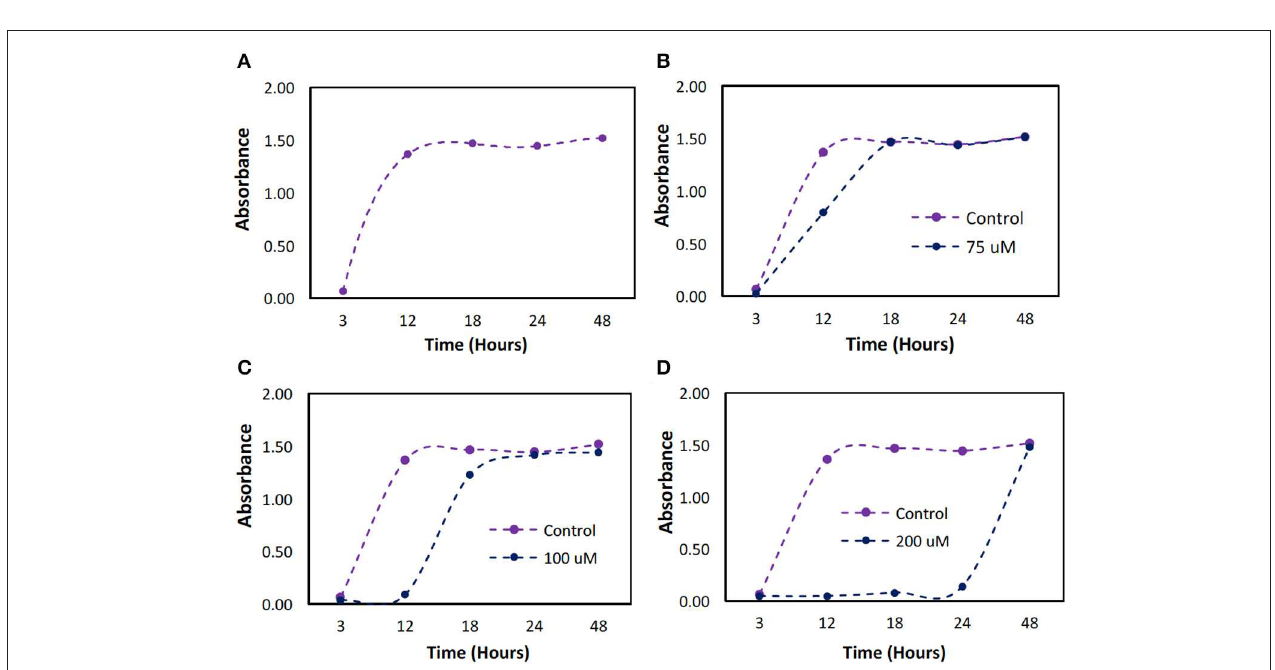
FIGURE 5 | Bacterial growth over a 48h period with different initial doses of hydrogen peroxide. P. cryohalolentis bacteria growth was measured using absorbance readings at 600nm with different initial doses of H 2 O 2 . (A) The control was used to determine typical bacterial growth. (B) Growth was first slowed at a dose of 75 µ M. (C) At 100 µ M dosing, bacteriostatic conditions were achieved. (D) At 200 µ M bacteriostatic conditions were maintained for 24h.